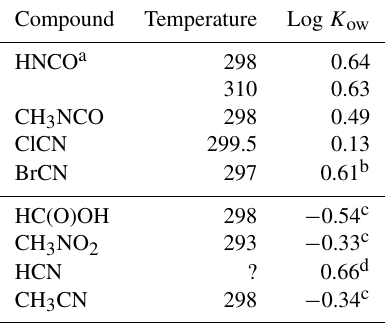
Table 4. Octanol/water partition coefficients for HNCO, CH 3 NCO, ClCN, and BrCN and related compounds.